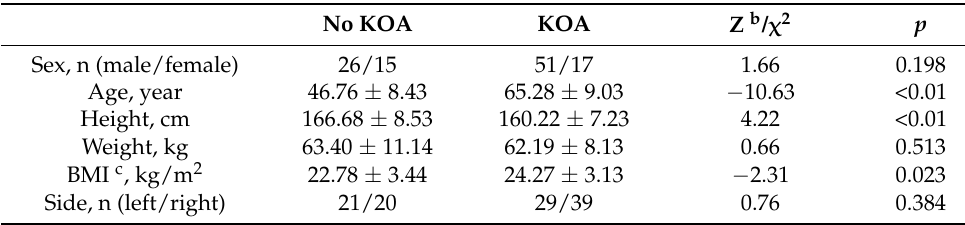
Table 1. Patient Characteristics Between the non-KOA a and KOA Groups.